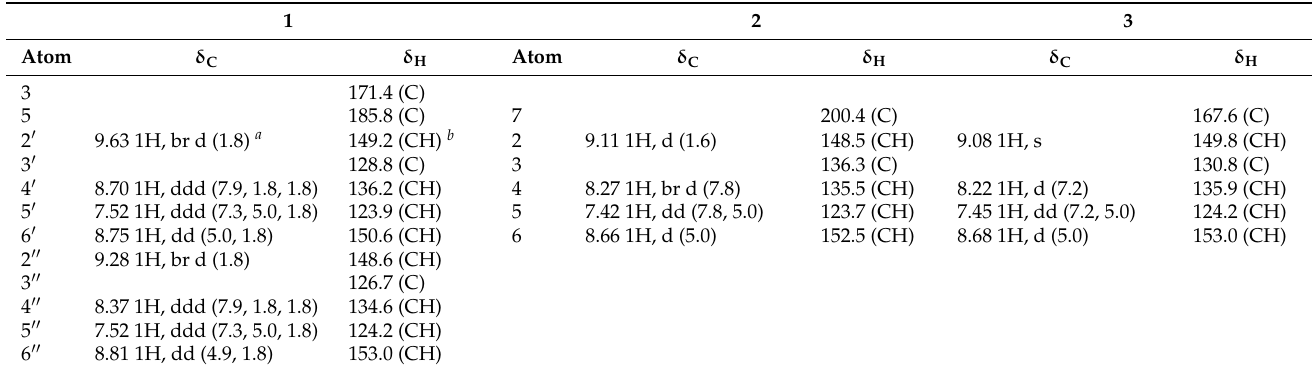
Table 1. 1 H and 13 C NMR data of compounds 1 – 3 in CDCl 3